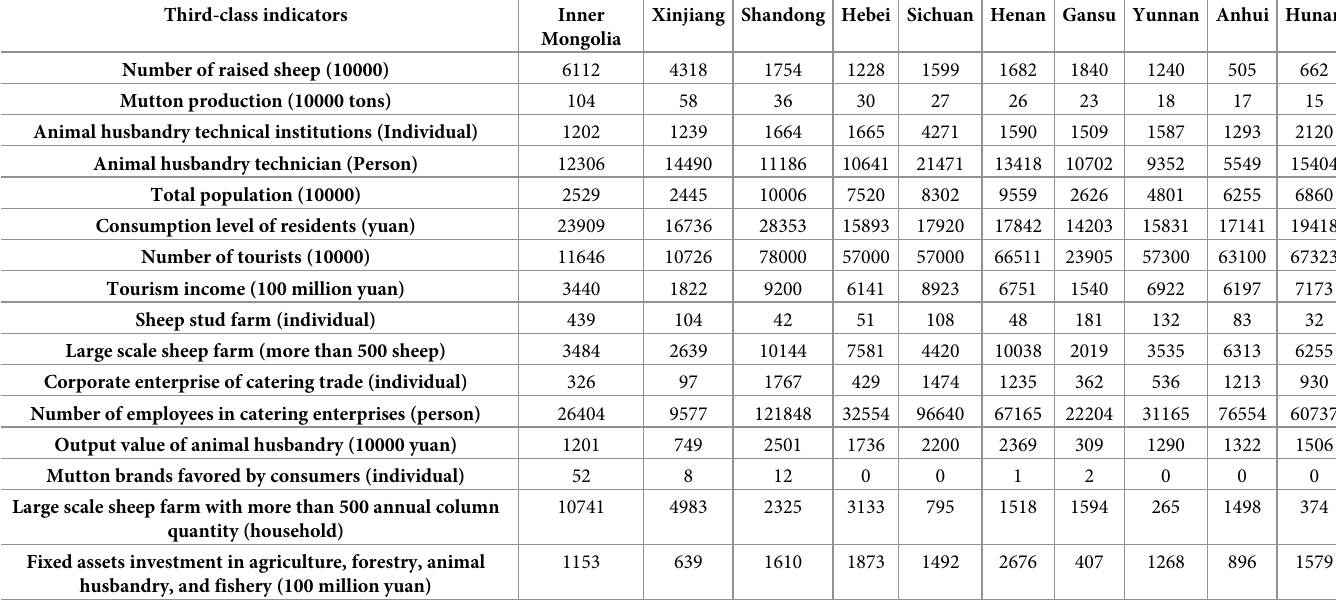
Table 2. The original data of the mutton index